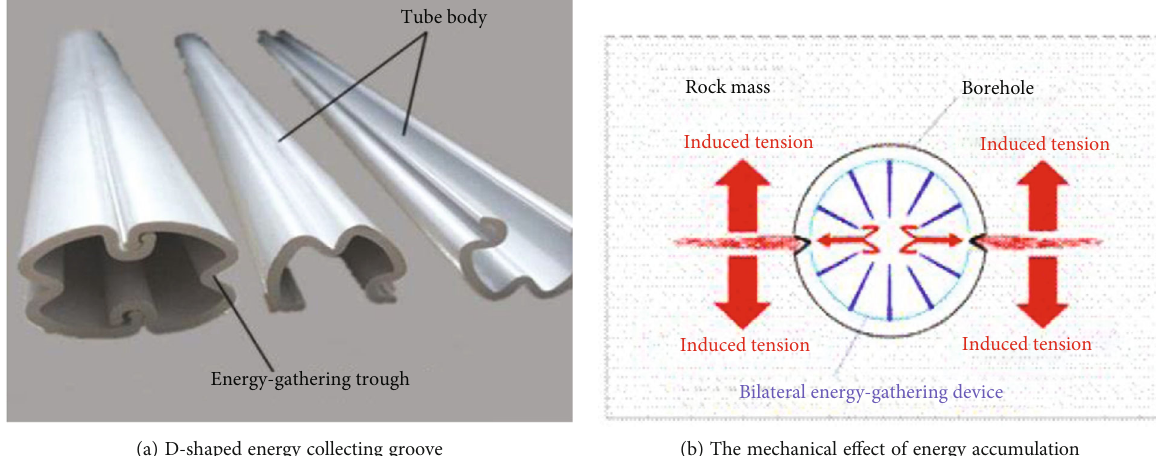
Figure 10: Mechanical model of double-sided energy-accumulating tension